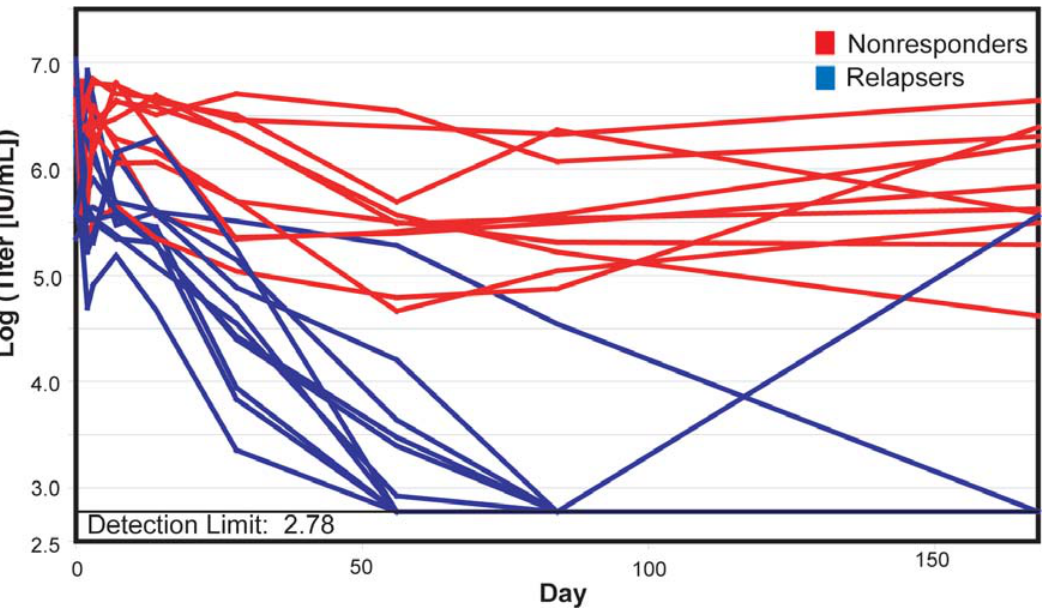
Figure 1. Viral titers in relapsers and nonresponders during the first 24 weeks of therapy. Viral titers are shown as the log(titers [IU/mL]) at each time point. All relapsers (blue) dropped to the detection limit. One of the relapsers had a rebound of viral titers during the first 24 weeks. All others had rebounds later in therapy. All nonresponders (red) declined by less than 2.1 log 10 .